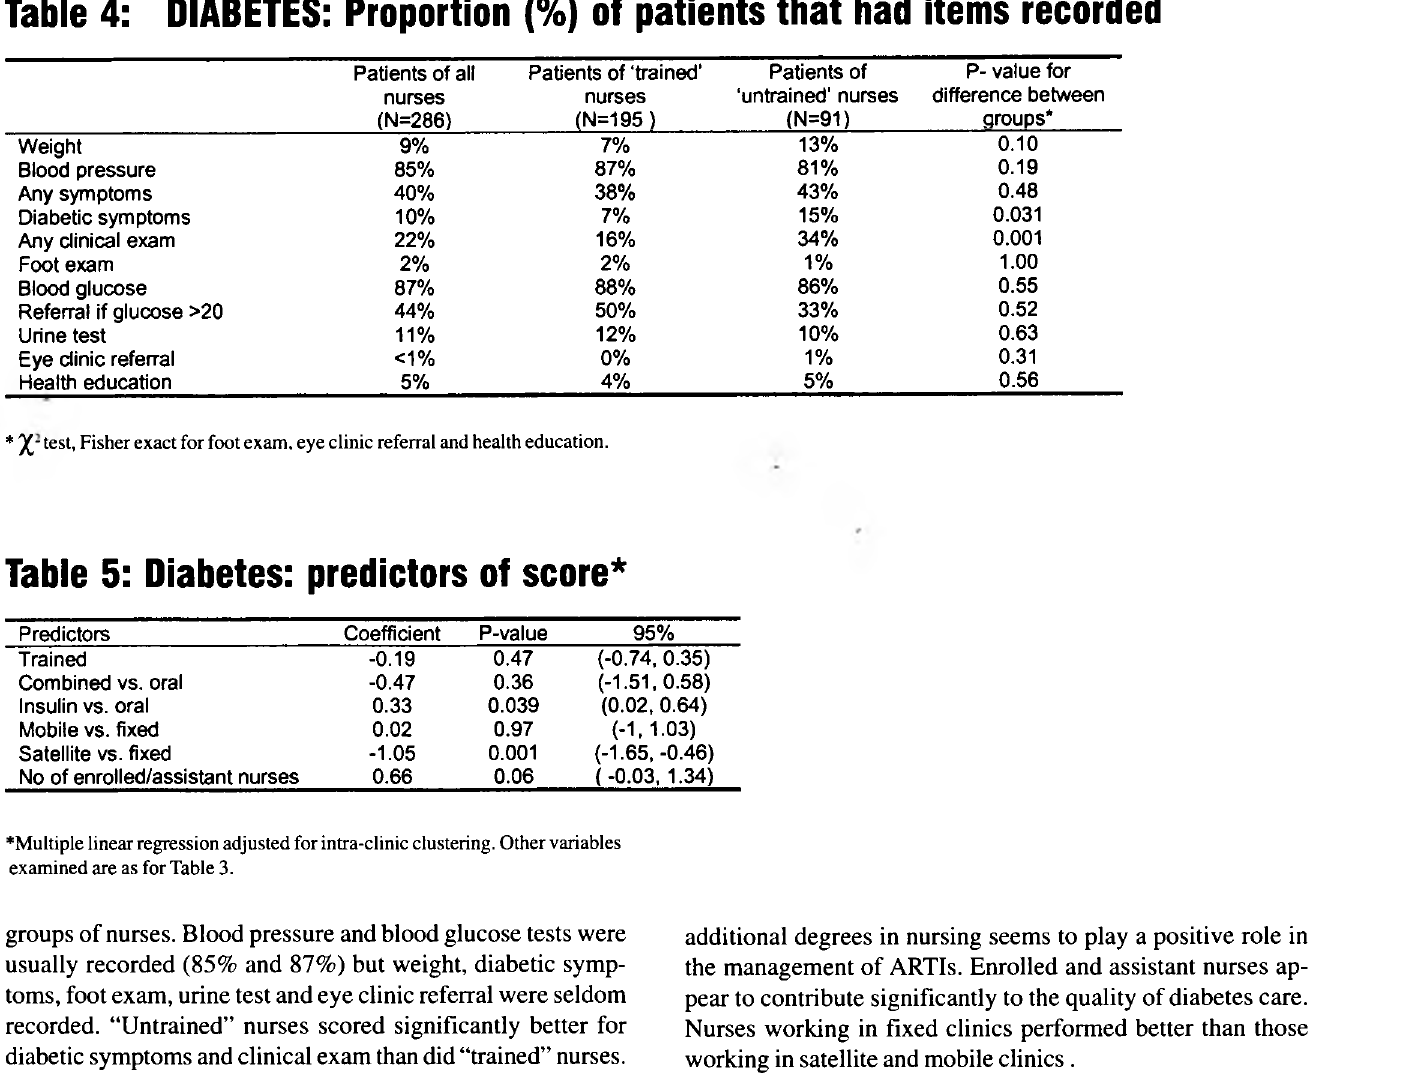
D IA B ETES : Proportion (% ) of patients that had items recorded